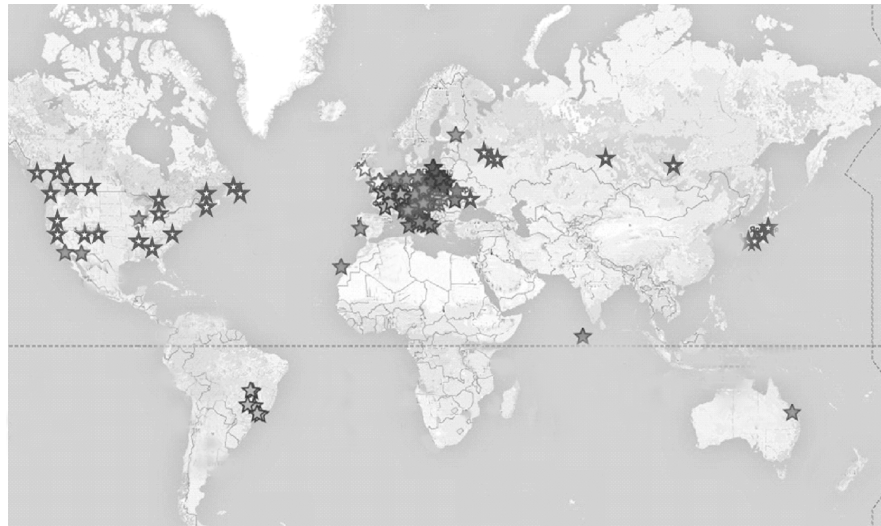
Fig. 4. The World Meteor Net and television meteor observation sites in Russia (Kartashova at al. 2014)